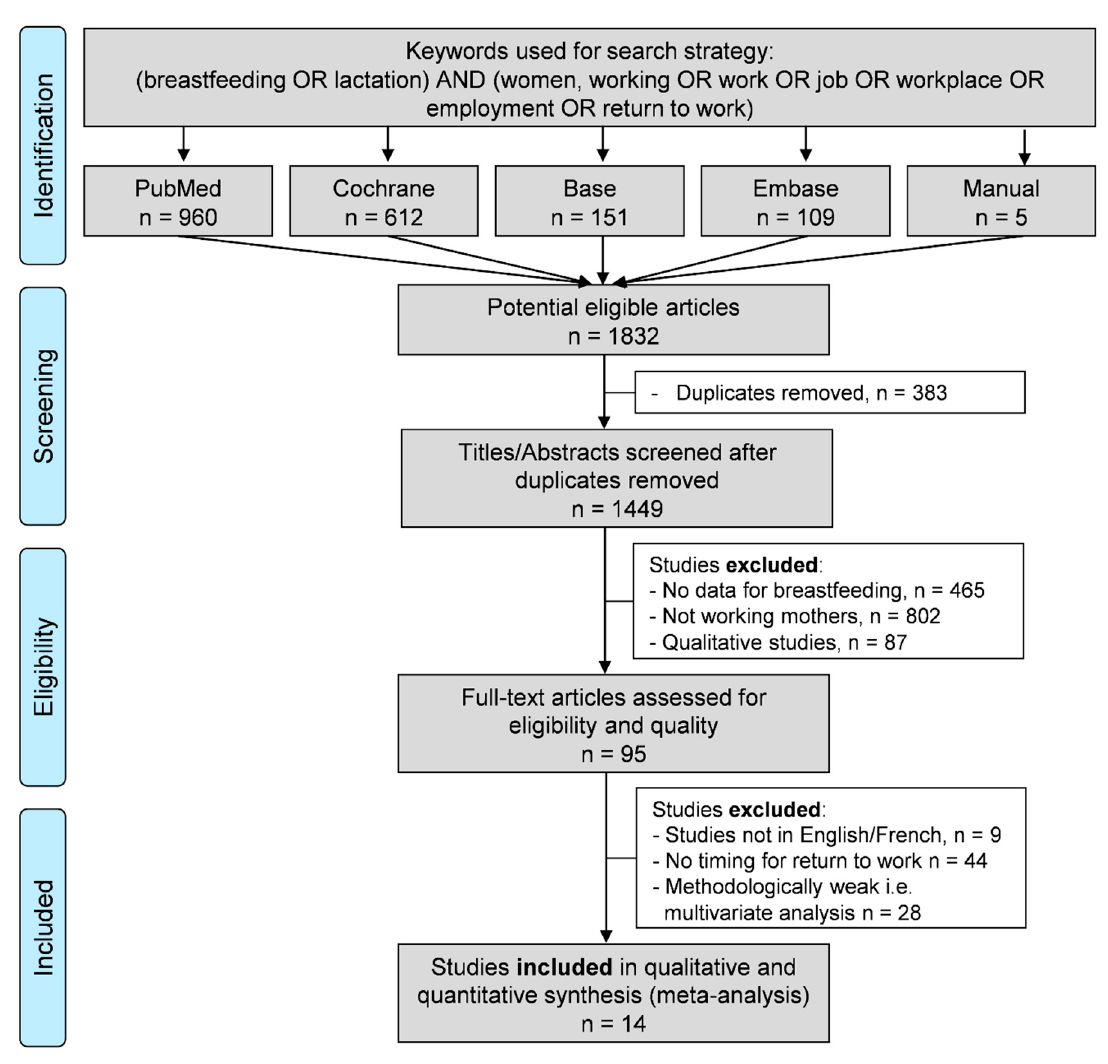
Figure 1. Search strategy.